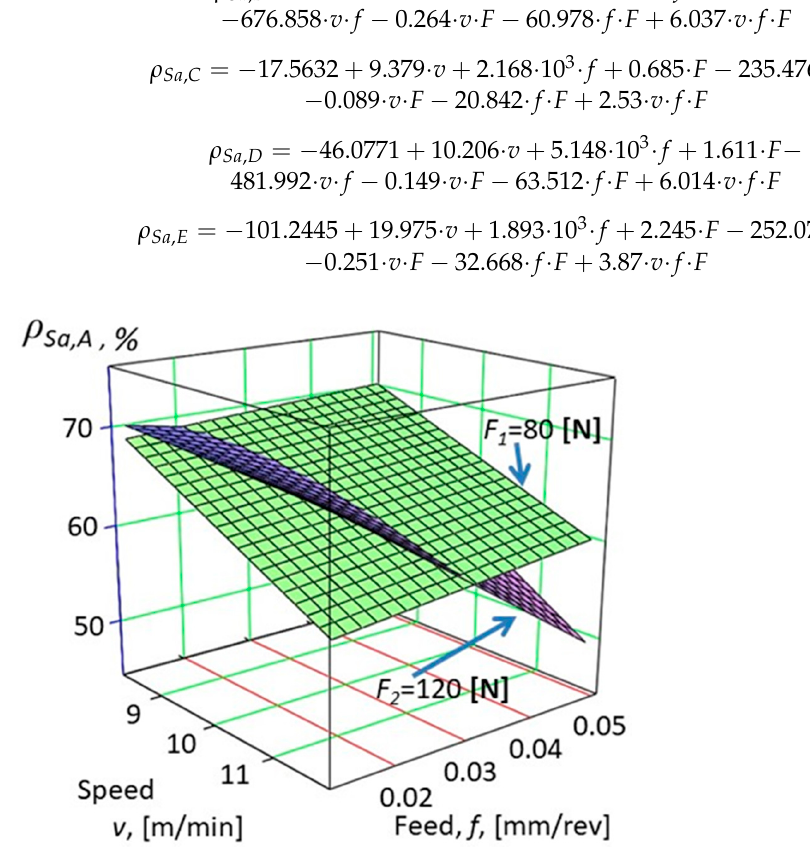
Figure 11. Improvement of the change of surface roughness ρ Sa , A on specimens marked A (see Equation (9)).